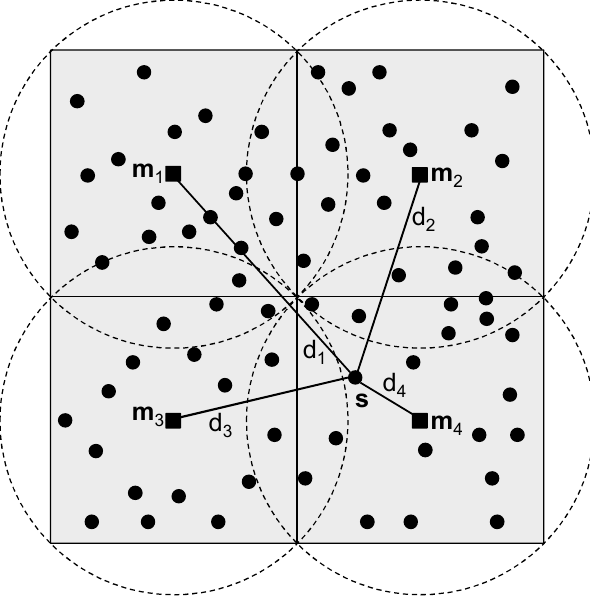
Figure 6. The observation domain with the black dots defines the locations at which the data are available. The black little squares indicate the nodes. The weights for each location s are related to the distances d i . The dashed circles define the radius for each